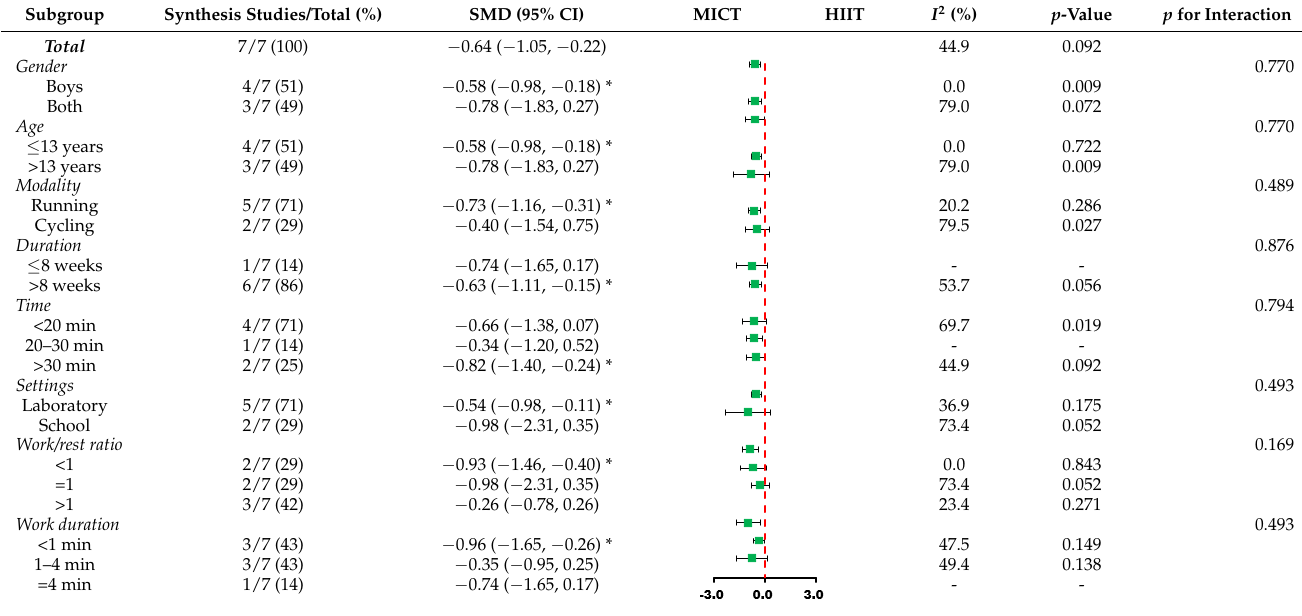
Table 4. Subgroup analysis of effects of HIIT vs. MICT on systolic blood pressure.